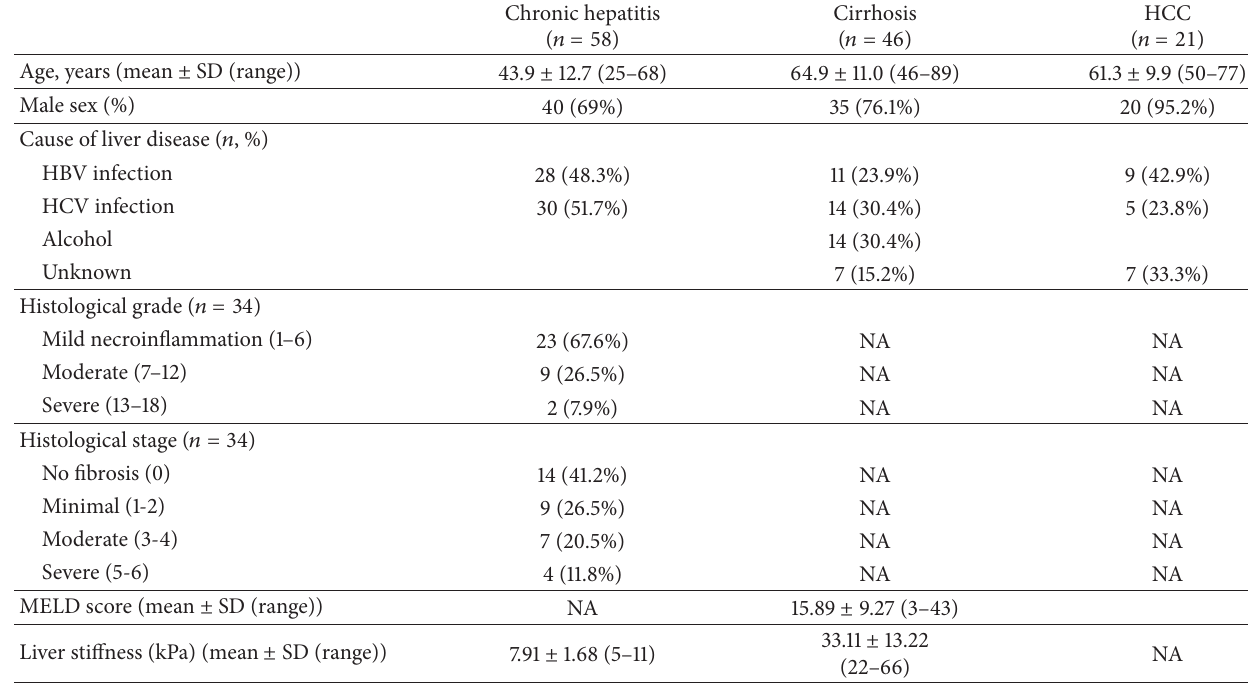
Table 1: Clinical and demographic characteristics of